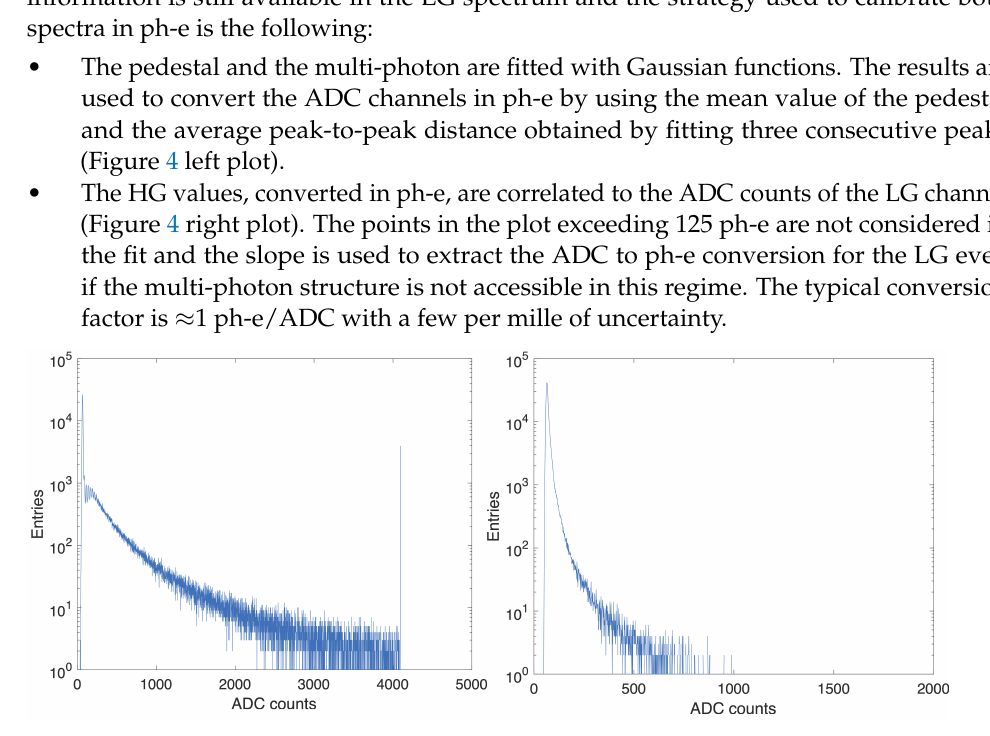
Figure 3. Two spectra obtained for the same SiPM with 6 GeV electrons at the DESY test beam. The spectrum on the left refers to the HG amplifiers while the results for the LG are shown on the